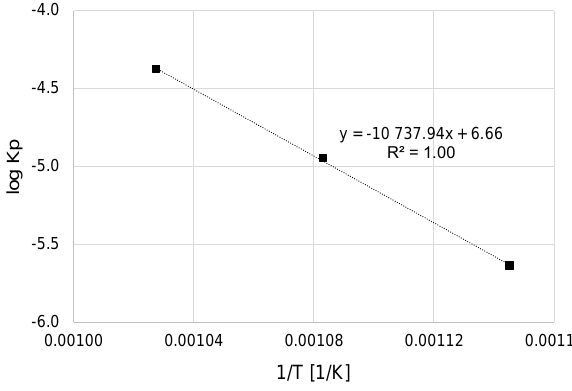
Figure 5. Arrhenius graph for titanium Grade 2 after cyclic oxidation at 600–700 °C for 72 h (12 cycles).